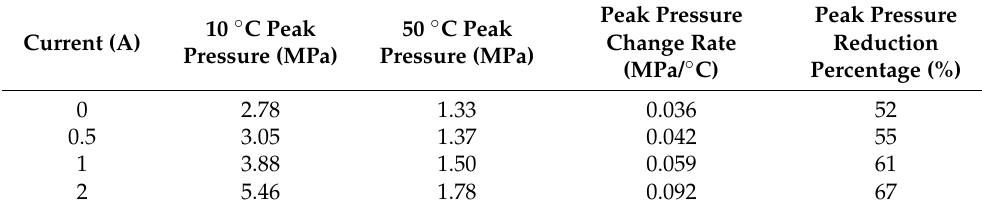
Table 3. Effect of temperature on peak pressure.